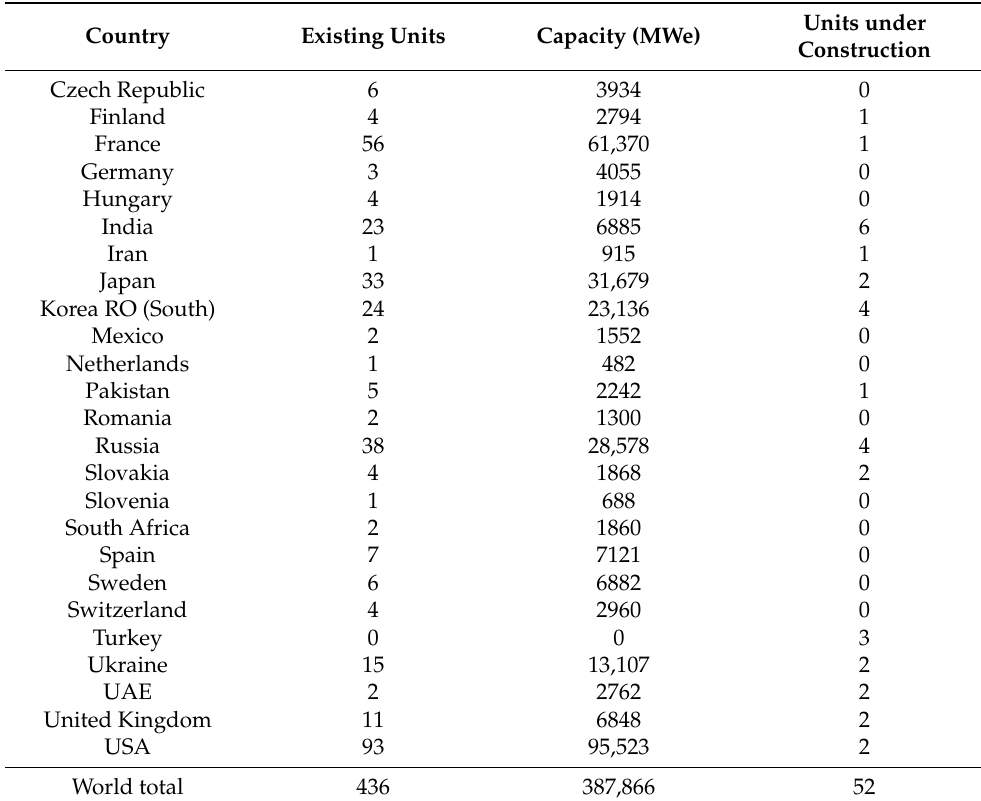
Table 3. Cont. Country